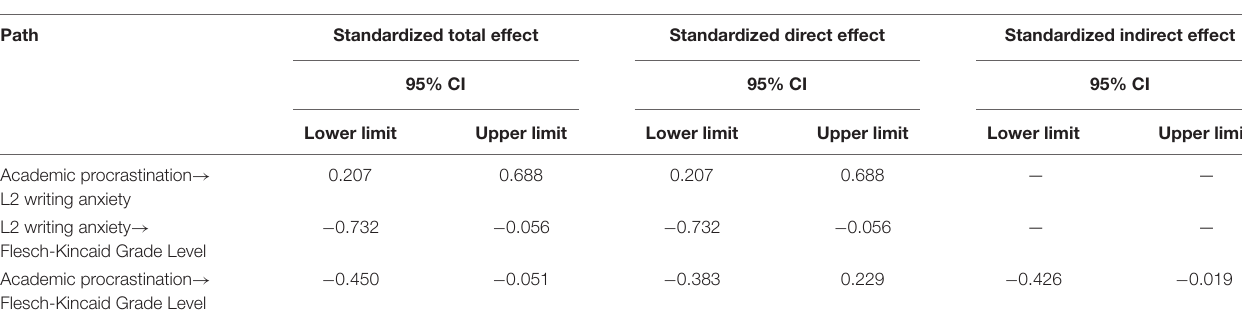
FIGURE 4 | The structural equation model. * p < 0.05; *** p < 0.001. TABLE 4 | Effect analysis of the